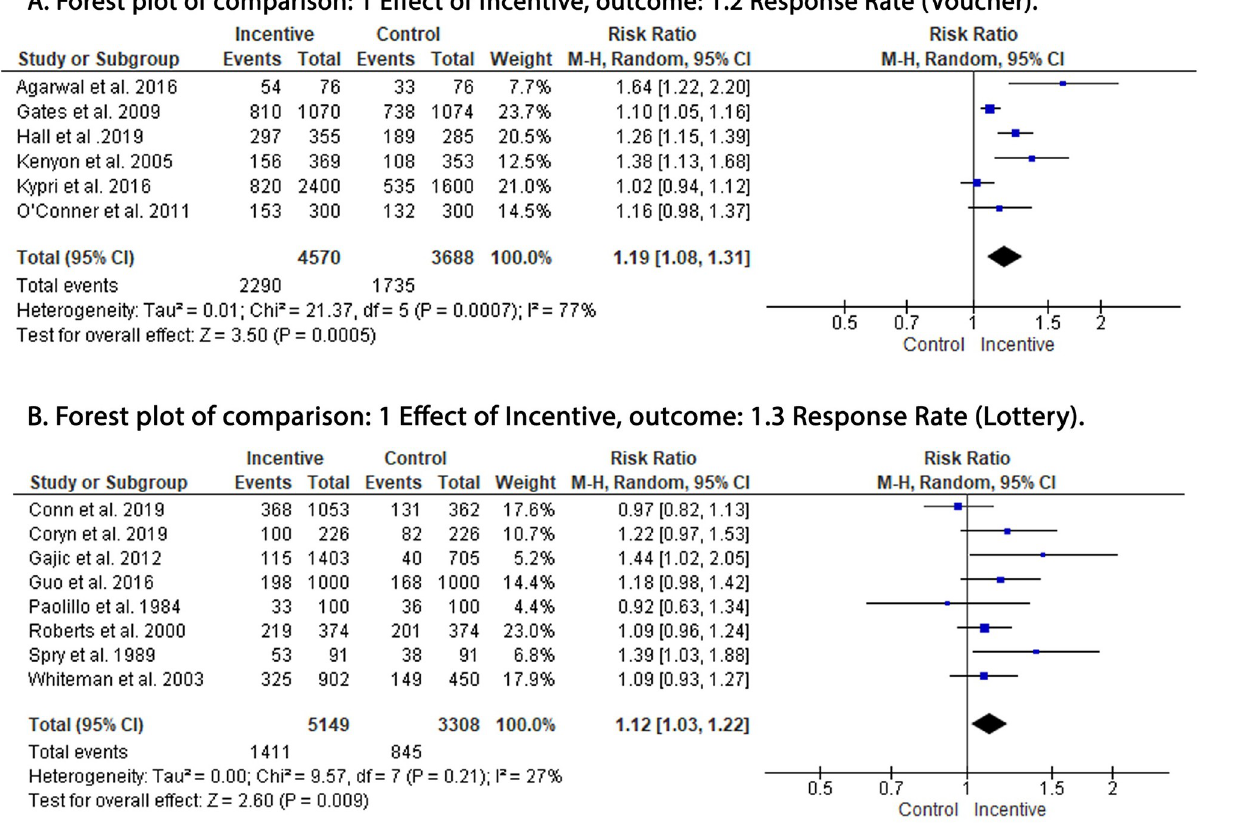
Fig 4. Forest plot of the effect of voucher and lottery in response rate. A: voucher; B: lottery. df: degrees of freedom; I 2 : I-squared; M-H: Mantel- Haenszel variance; CI: confidence interval.